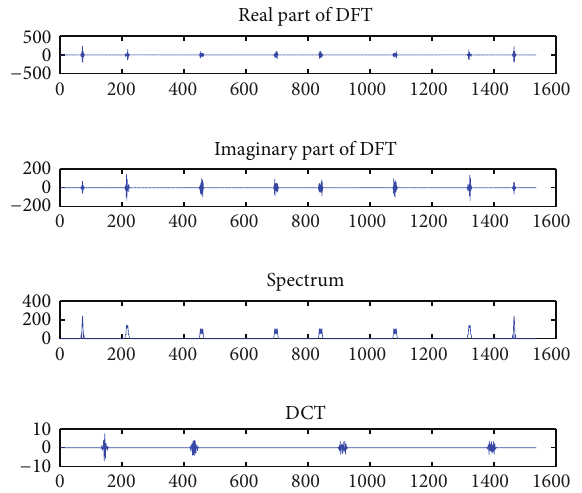
Figure3:ComparisonofcoefficientsofDCTandDFTforwideband signal.